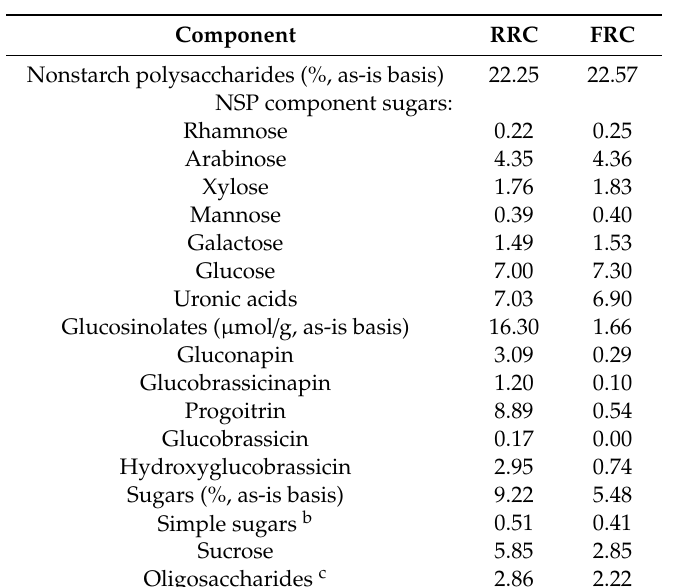
Table 2. Chemical composition of raw rapeseed cake (RRC) and fermented rapeseed cake (FRC) a in experiments 1, 2, and